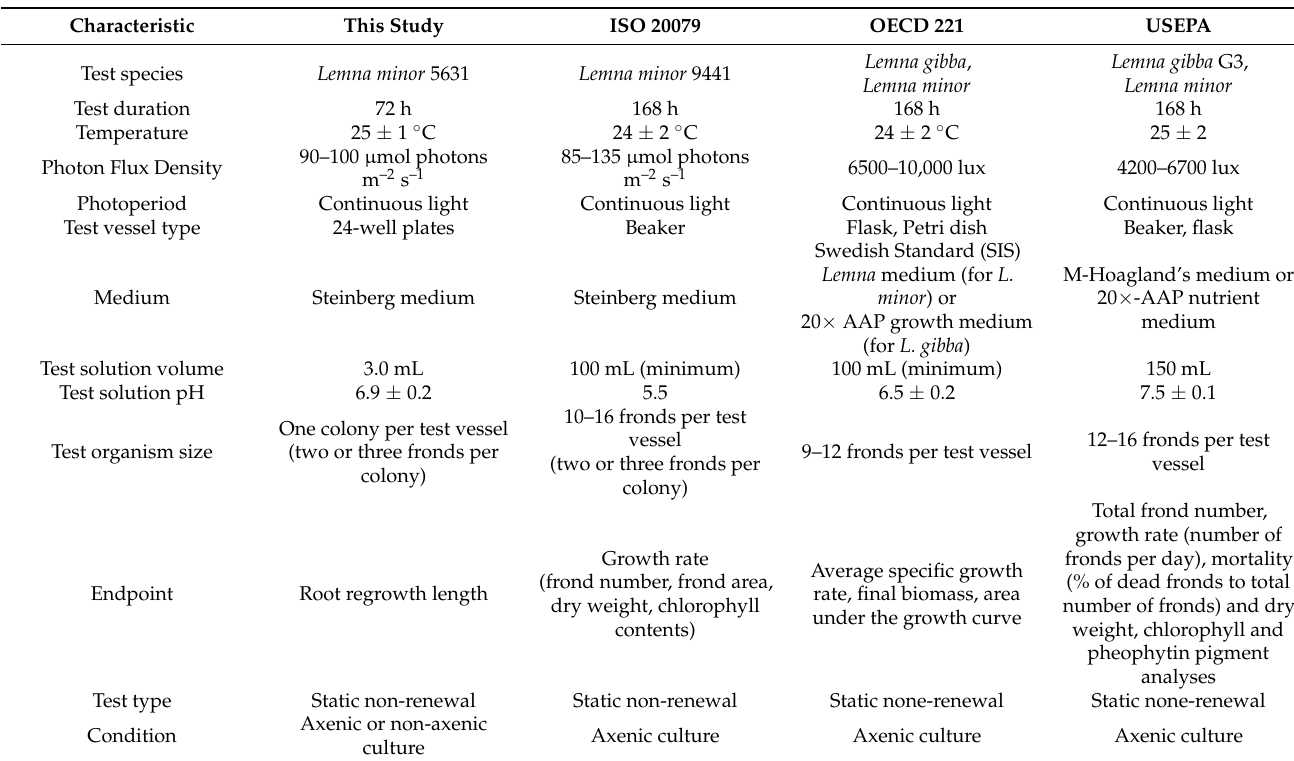
Table 1. Comparison of the test conditions used for the root-regrowth assay described in the current study and three internationally standardized